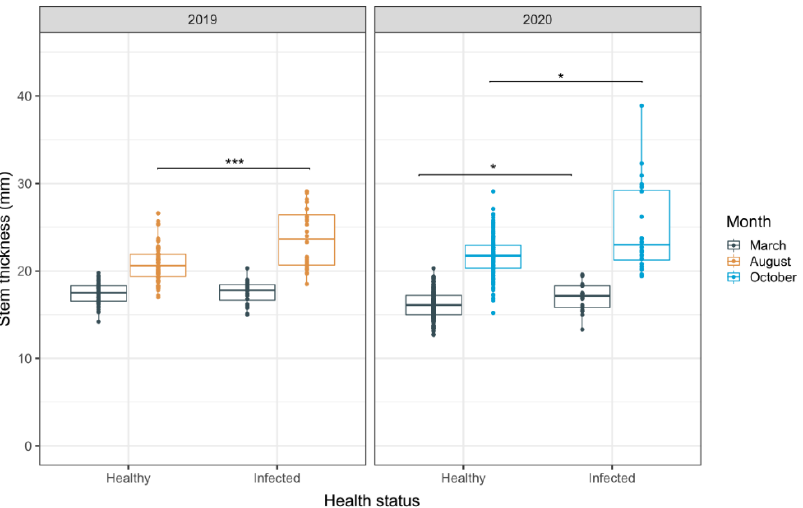
Figure 4. Comparison of stem thickness of healthy and infected plants at the beginning and towards the end of both greenhouse trials. Plants were classified as healthy if no HRD symptoms were observed at the end of the trial (N = 67 and N = 172 in greenhouse trial of 2019 and 2020, respectively), whereas plants showing HRD symptoms by the end of the experiment were classified as infected (N = 28 and N = 20 in greenhouse trial of 2019 and 2020, respectively). Stem thickness (expressed in mm) was monitored at the beginning (March) and towards the end of the trial (August and October for the 2019 and 2020 trial, respectively). Significance differences between healthy and diseased plants are indicated. p -values < 0.05 are represented by *, and those <0.001 are represented by ***.